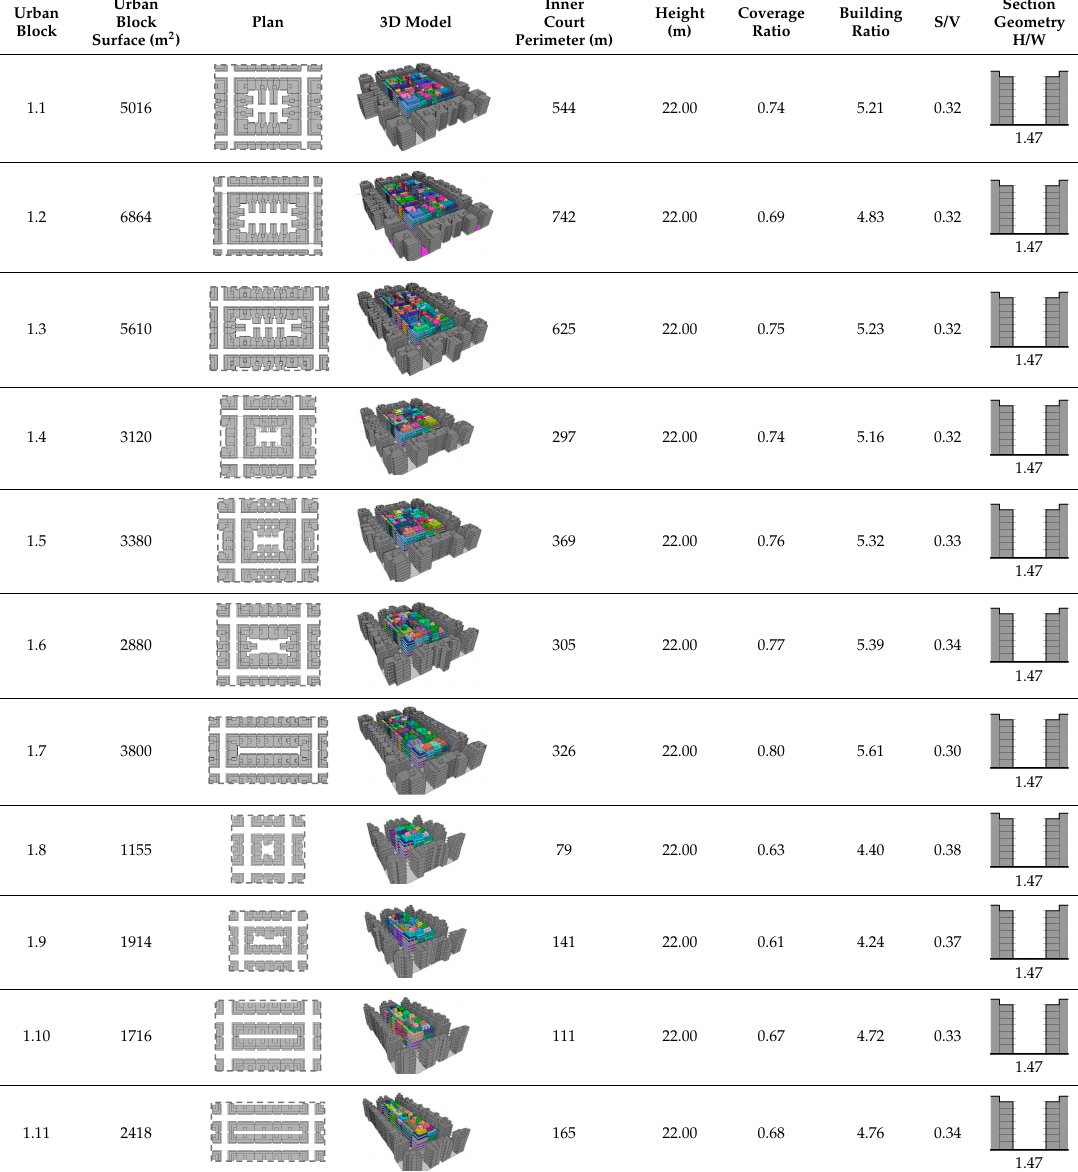
Table 1. Form and geometry parameters of typical urban blocks included in group 1.